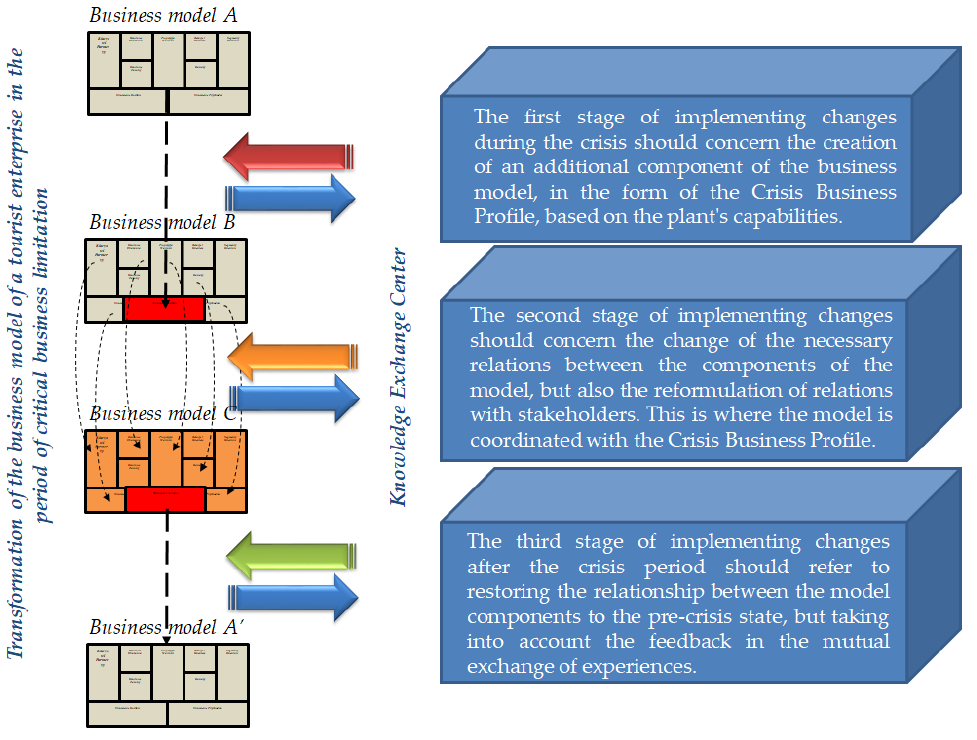
Figure 3. Transformation of the business model and the process of feedback in the exchange of knowledge with the knowledge exchange center. Source: own study.